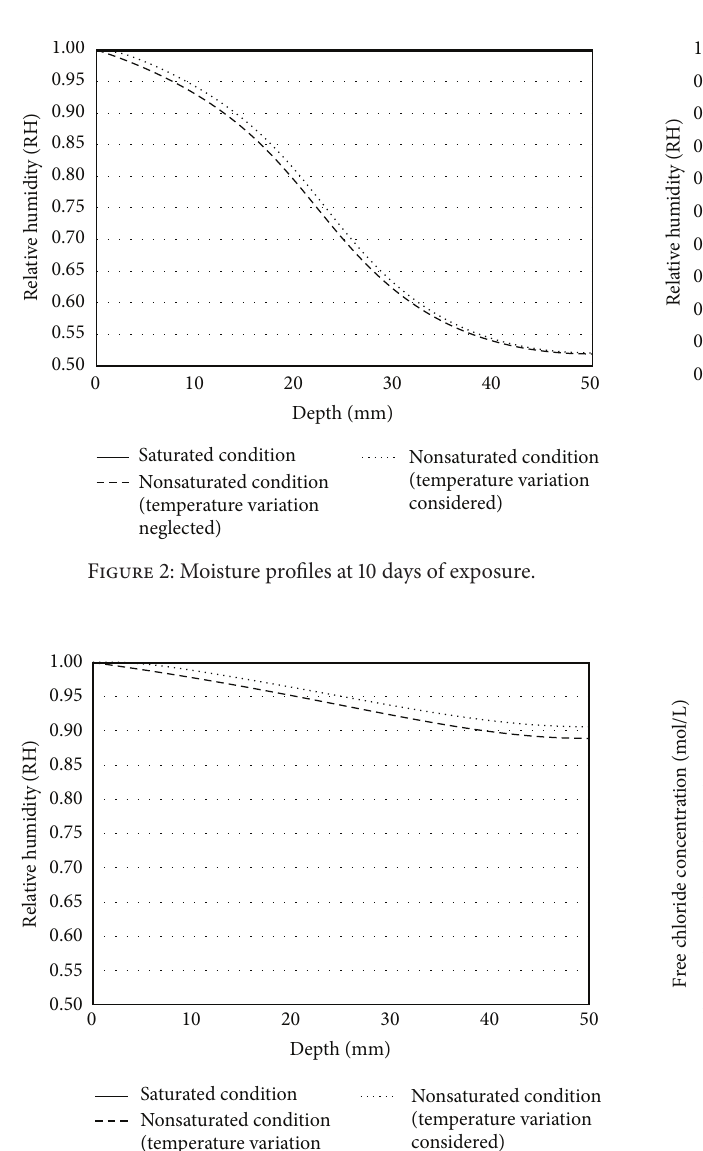
Figure 5: Free chloride concentration profiles at different times of